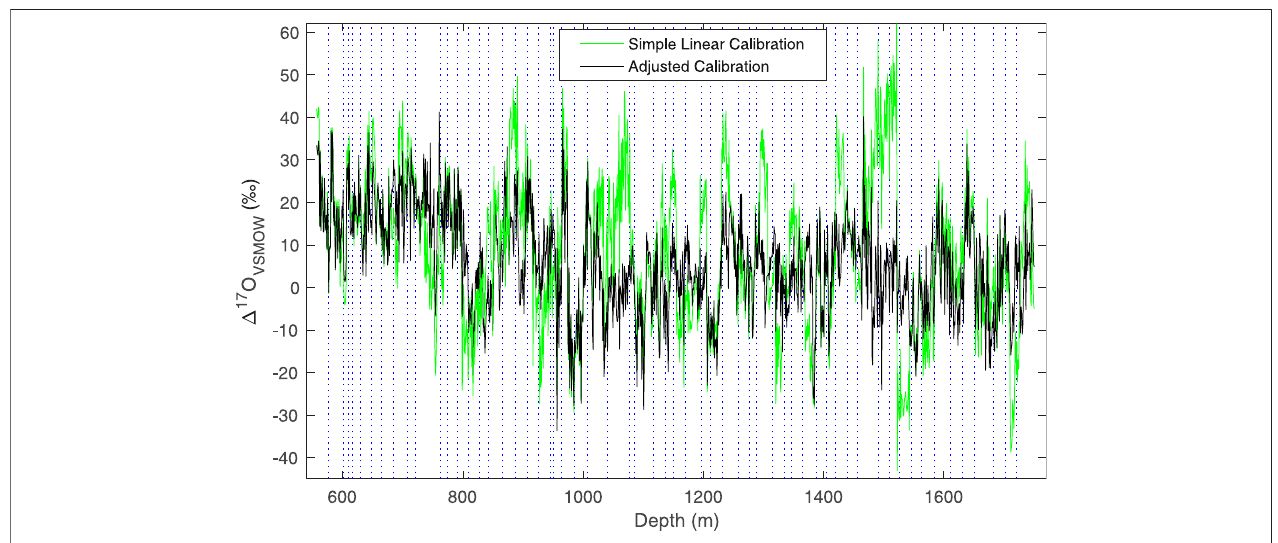
FIGURE 6 | Comparison of 100 cm average Δ 17 O data for the South Pole ice core, calibrated with a simple linear calibration (green, Eq. 7 ) with two reference waters,andanadjustedcalibration(gray, Eq.10 )usingfourreferencewaters.Notetheincreasedvarianceandabrupttransitionsintheun-adjusteddata.Dashedvertical lines de fi ne the boundary between different analysis days.